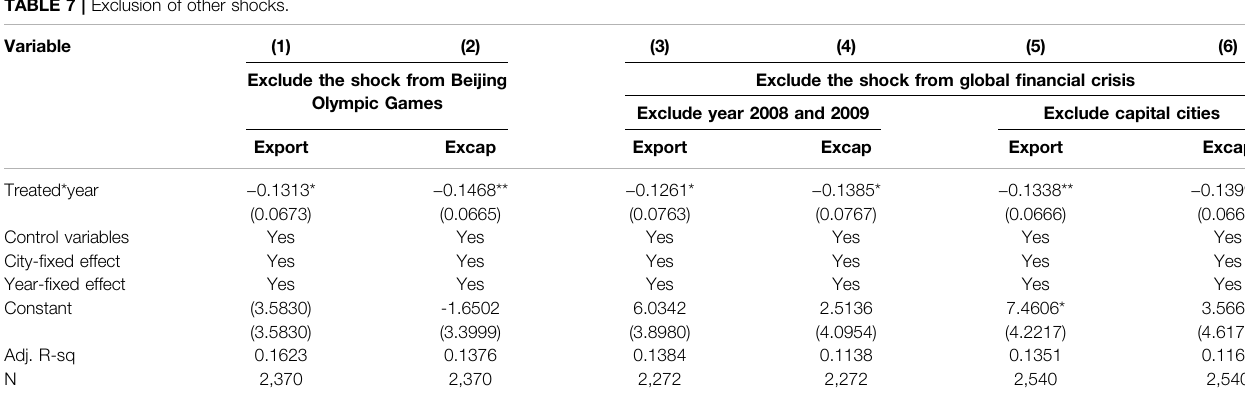
TABLE 7 | Exclusion of other